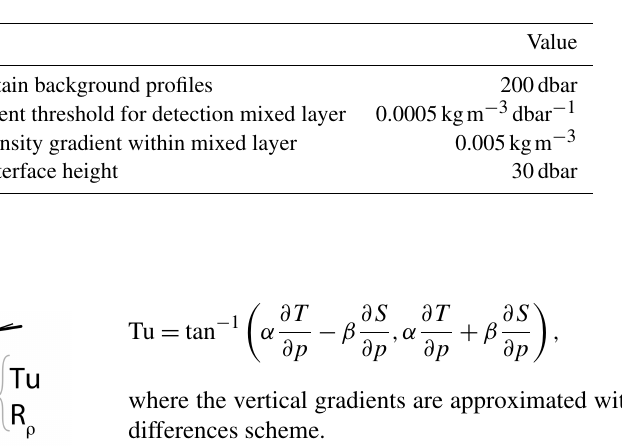
Figure 2. Observation density of the number of profiles obtained from the Argo floats and Ice-Tethered Profilers after quality control (km − 2 ). Observation density is binned per degree longitude and degree latitude. Empty bins indicate that no data were available at that location. Table 2. Input parameters applied during the data preparation and the algorithm as used in this study. The sensitivity of the output of the algorithm to the input variables is discussed in the Sect. 4.